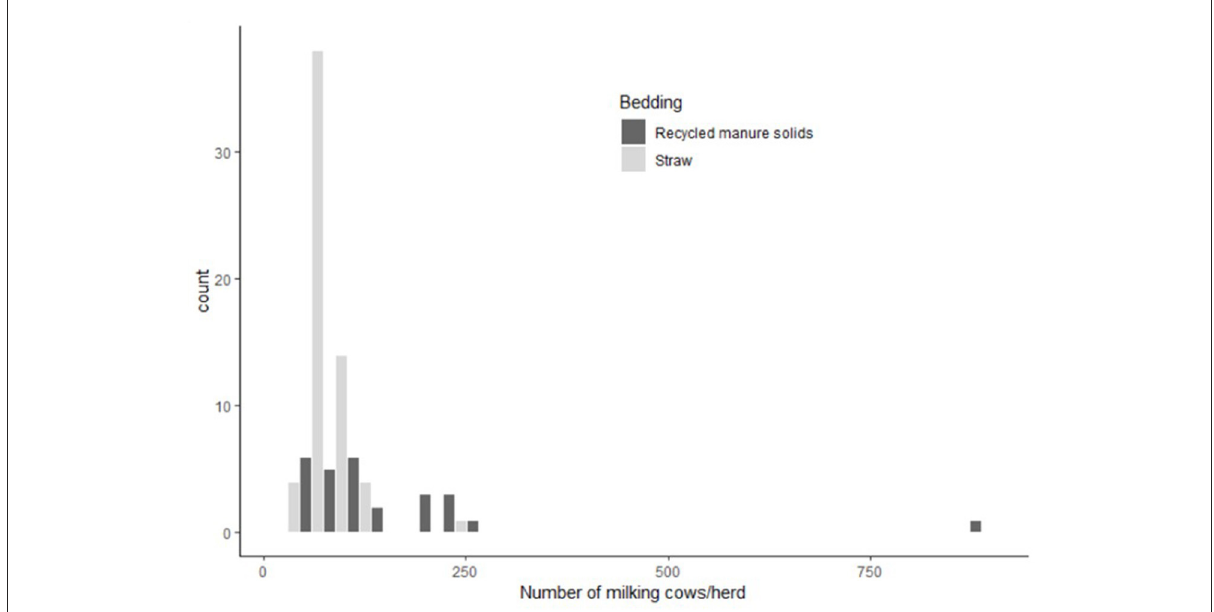
FIGURE1 Distribution of number of milking cows in the sampled herds as function of bedding type used (in the histogram, bins with equivalent number of milking cows in recycled manure solids vs. straw-bedded herds are presented next to each other to facilitate viewing).